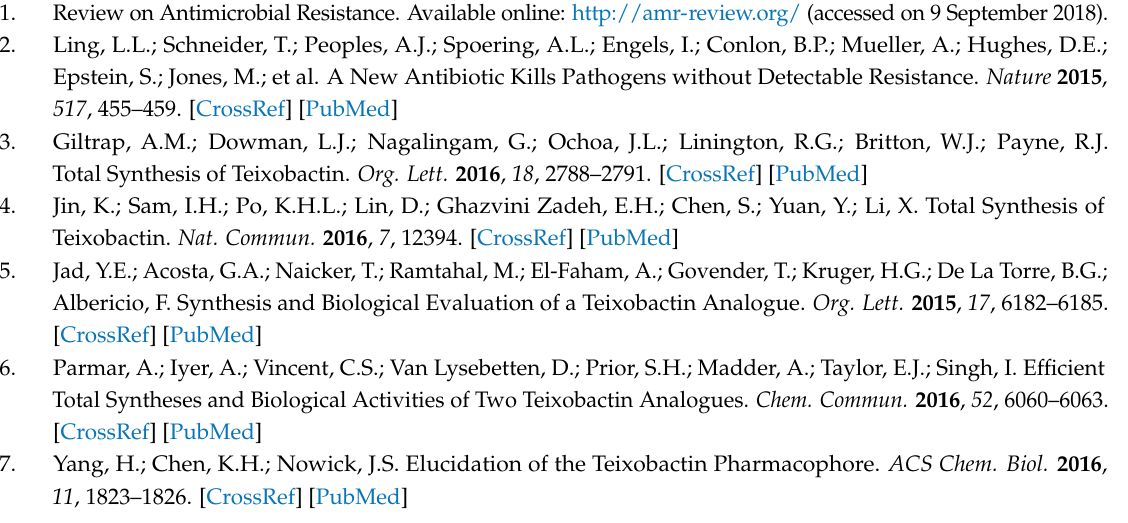
Table S1: Compound number, name, chemical formula, exact mass and mass found for compounds 2–9. Figure S1: HPLC trace of purified teixobactin analogue 2 (gradient: 5–95% ACN in 25 min using. A: 0.1% HCOOH in water, B: ACN). Figure S2: ESI-MS of purified teixobactin analogue 2 . Exact mass calcd. For C 53 H 90 N 16 O 14 S 2 = 1238.63, found M + H + = 1239.62, M/2 + H + = 620.38. Figure S3: HPLC trace of purified teixobactin analogue 3 (gradient: 5–95% ACN in 25 min using A: 0.1% HCOOH in water, B: ACN). Figure S4: ESI-MS of purified teixobactin analogue 3 . Exact mass calcd. For C 53 H 88 N 16 O 14 S 2 = 1236.61, found M + H + = 1237.72, M/2 + H + = 619.47. Figure S5: HPLC trace of purified teixobactin analogue 4 (gradient: 5–95% ACN in 25 min using A: 0.1% HCOOH in water, B: ACN). Figure S6: ESI-MS of purified Teixobactin analogue 4 . Exact mass calcd. For C 53 H 90 N 16 O 14 S 2 = 1238.63, found M + H + = 1239.57, M/2 + H + = 620.76. Figure S7: HPLC trace of purified teixobactin analogue 5 (gradient: 5–95% ACN in 25 min using A: 0.1% HCOOH in water, B: ACN). Figure S8: ESI-MS of purified teixobactin analogue 5 . Exact mass calcd. For C 53 H 88 N 16 O 14 S 2 = 1236.61, found M + H + = 1237.53, M/2 + H + = 619.53. Figure S9: HPLC trace of purified teixobactin analogue 6 (gradient: 5–95% ACN in 25 min using A: 0.1% HCOOH in water, B: ACN). Figure S10: ESI-MS of purified teixobactin analogue 6 . Exact mass calcd. For C 53 H 90 N 16 O 14 S 2 = 1238.63, found M + H + = 1239.57, M/2 + H + = 620.76. Figure S11: HPLC trace of purified teixobactin analogue 7 (gradient: 5–95% ACN in 25 min using A: 0.1% HCOOH in water, B: ACN). Figure S12: ESI-MS of purified teixobactin analogue 7 . Exact mass calcd. For C 53 H 88 N 16 O 14 S 2 = 1236.61, found M + H + = 1237.56, M/2 + H + = 619.36. Figure S13: HPLC trace of purified teixobactin analogue 8 (gradient: 5–95% ACN in 25 min using A: 0.1% HCOOH in water, B: ACN). Figure S14: ESI-MS of purified teixobactin analogue 8 . Exact mass calcd. For C 54 H 92 N 16 O 14 S 2 = 1252.64, found M + H + = 1253.64, M/2 + H + = 627.44. Figure S15: HPLC trace of purified teixobactin analogue 9 (gradient: 5–95% ACN in 25 min using A: 0.1% HCOOH in water, B: ACN). Figure S16. ESI-MS of purified teixobactin analogue 9 . Exact mass calcd. For C 54 H 90 N 16 O 14 S 2 = 1250.63, found M + H + = 1251.63, M/2 + H + =